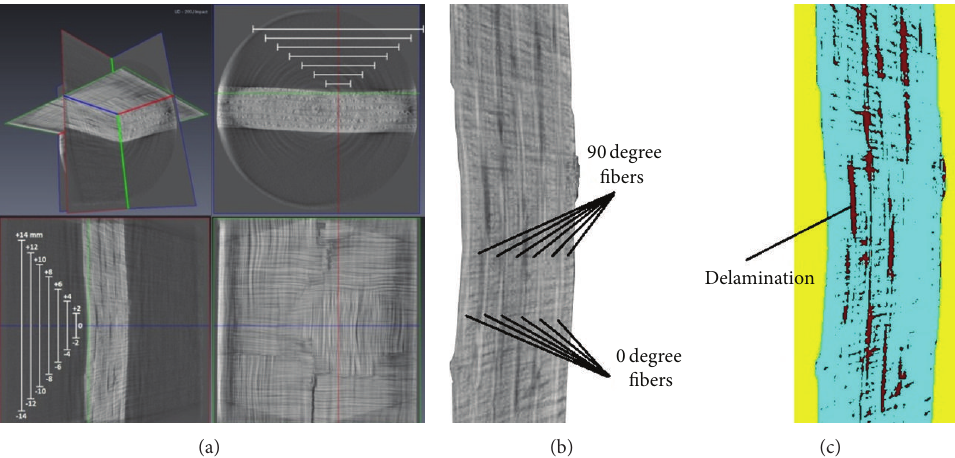
Figure 10: (a) XMT image of impacted UD laminate (top view at the impact center, left view at 10mm to the impact center, and front view close to the rear side of impact), (b) enlarged left view within a cropped window of 25mm × 10mm, and (c) the processed image of left view at the impact center.